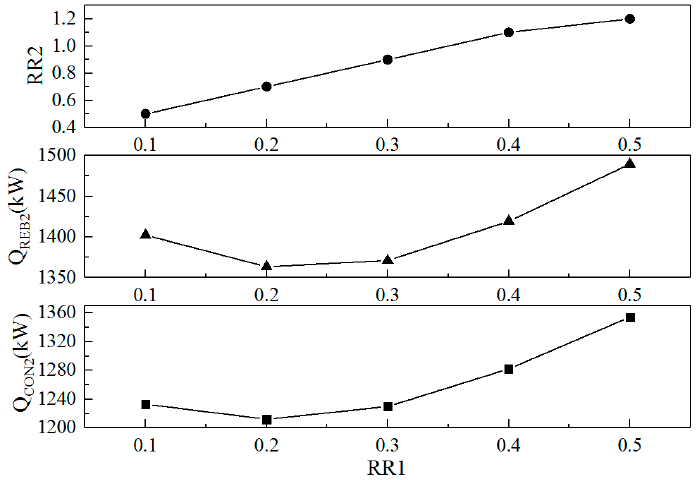
Figure 5. Effect of the reflux ratio RR1 in the low pressure column (LPC).